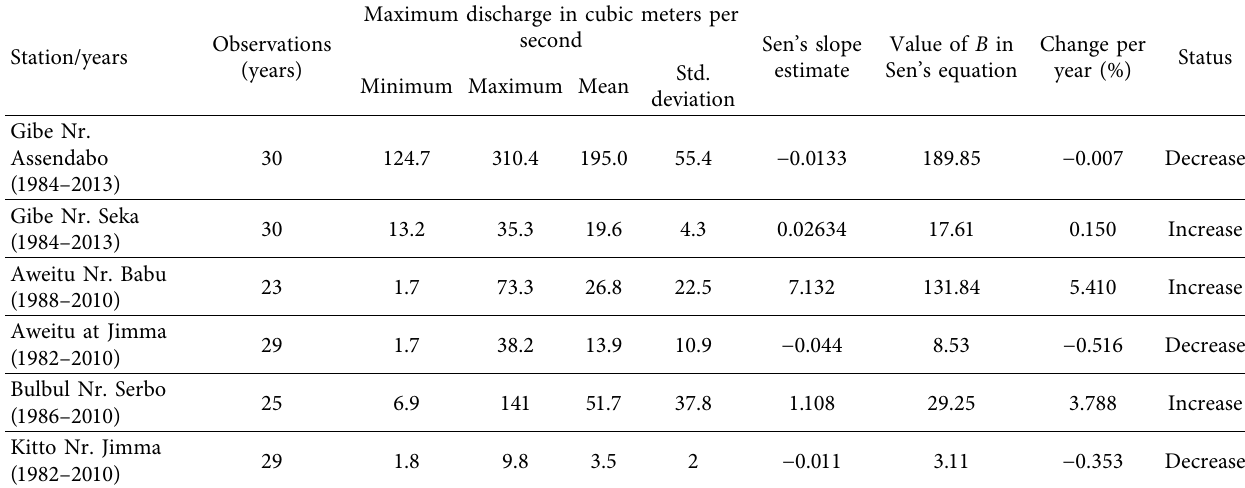
Table 6: Summary of the true slopes of the existing trend for stream